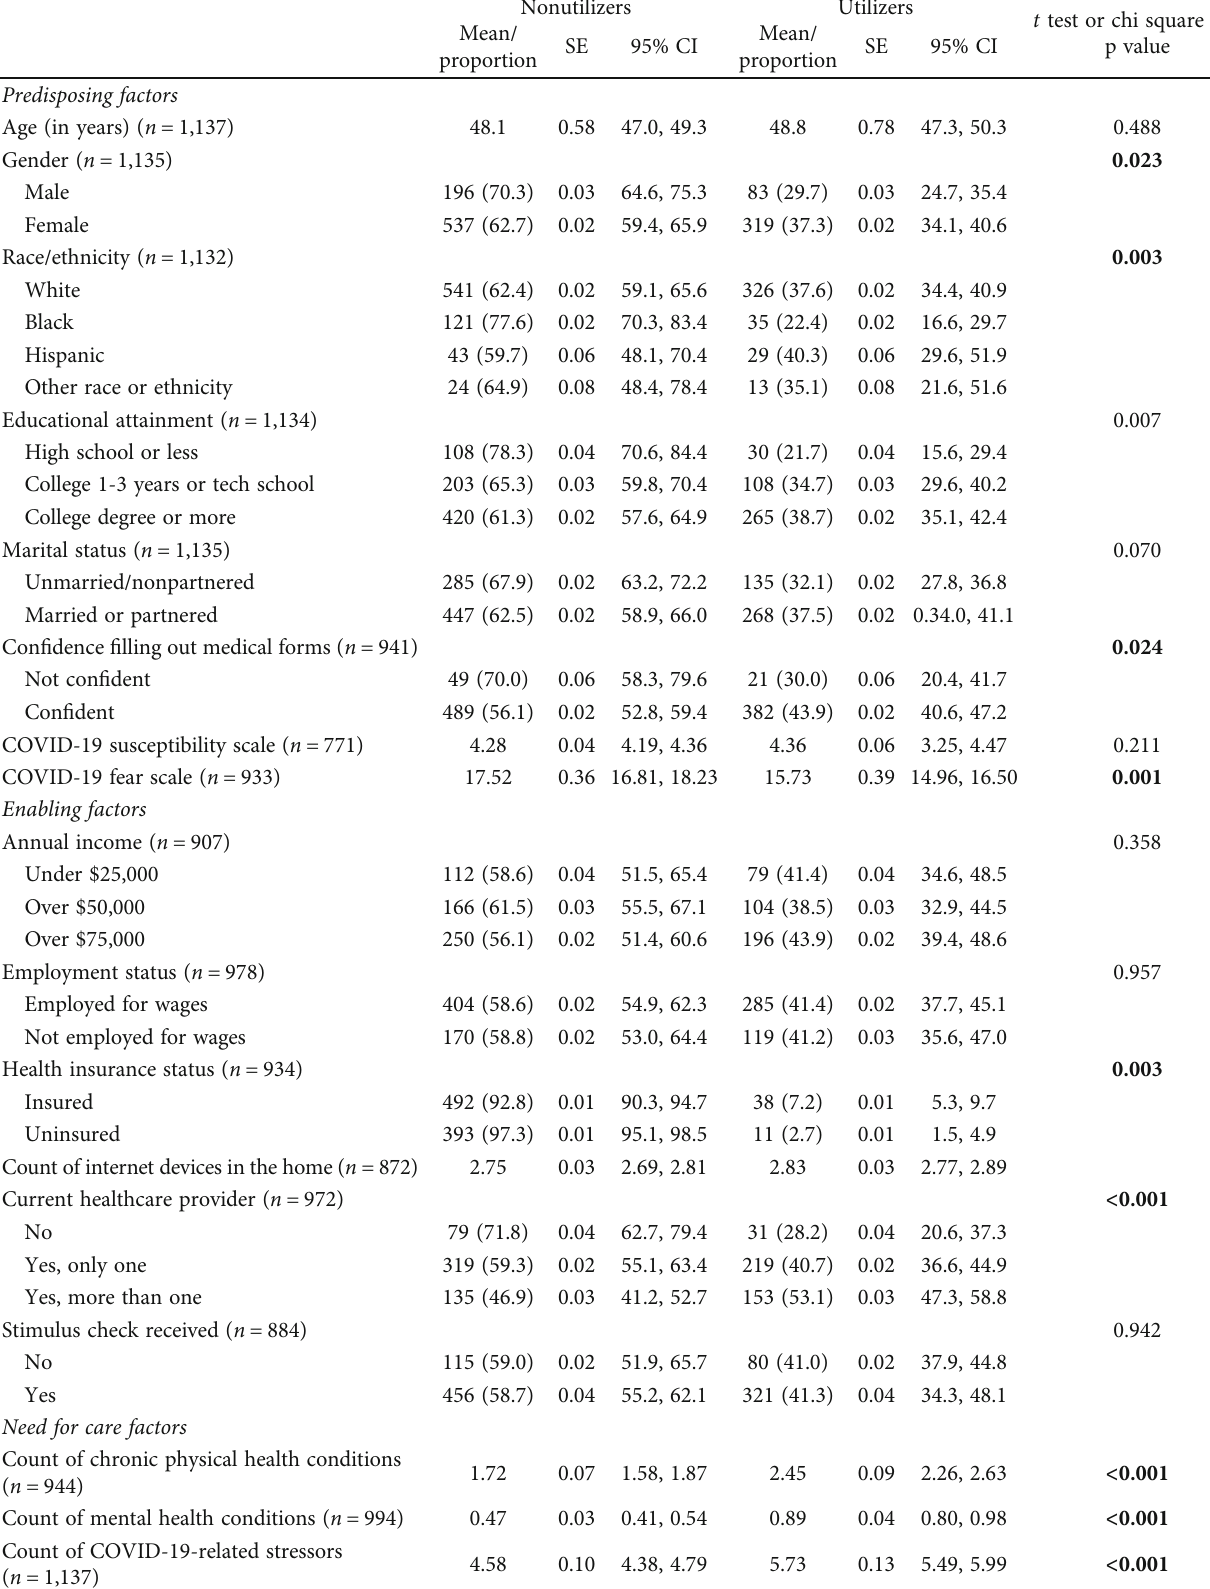
Table 1: Characteristics of sample, overall, and telehealth utilization ( n = 1,137